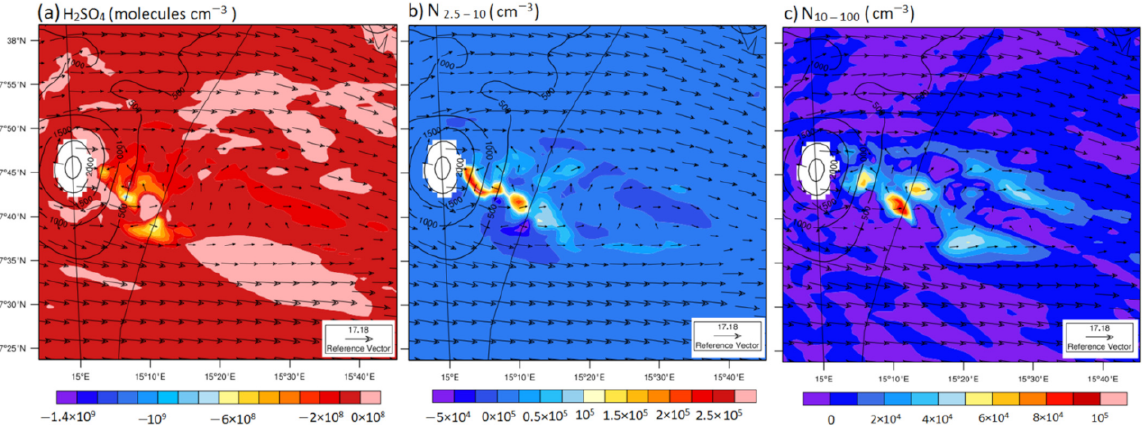
Figure 6. The same as Figure 3b,d, except for differences (S1–S2) in simulated values for (H 2 SO 4 ) ( a ), concentrations of ~2.5–10 nm sized particles (N 2.5-10 ) ( b ), and concentrations of 10–100 nm-sized particles (N 10-100 ) ( c